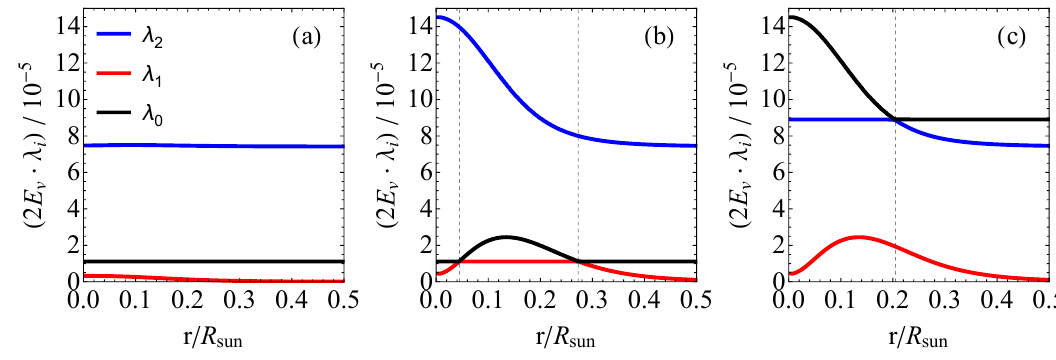
Figure 2 . 2 E ν λ i as a function of the propagation distance in the Sun. The left panel: (a) R ∆ = 0 . 15 , E ν = 0.5 MeV; The middle panel: (b) R ∆ = 0 . 15 , E ν = 10 MeV; The right panel: (c) R ∆ = 1 . 20 , E ν = 10 MeV. The mixing angle θ 01 is fixed to be sin 2 2 θ 01 = 5 × 10 − 4 . Other oscillation parameters are the same as those in figure